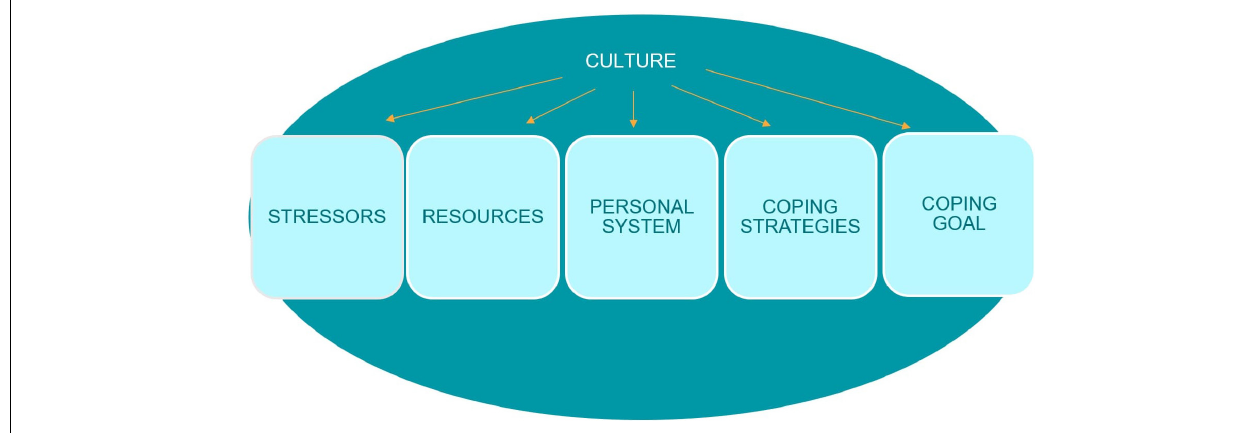
FIGURE 1 | Culture’s influence on the coping model, adapted by Kuo (2013) based on Chun et al. (2006). Included courtesy of the